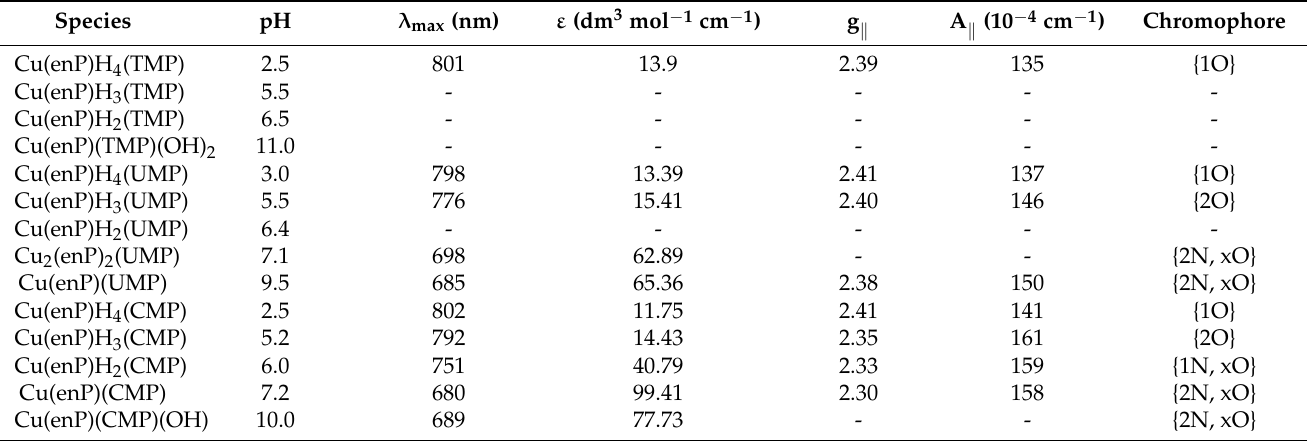
Table 5. Spectral parameters from UV-Vis and EPR studies for ternary systems